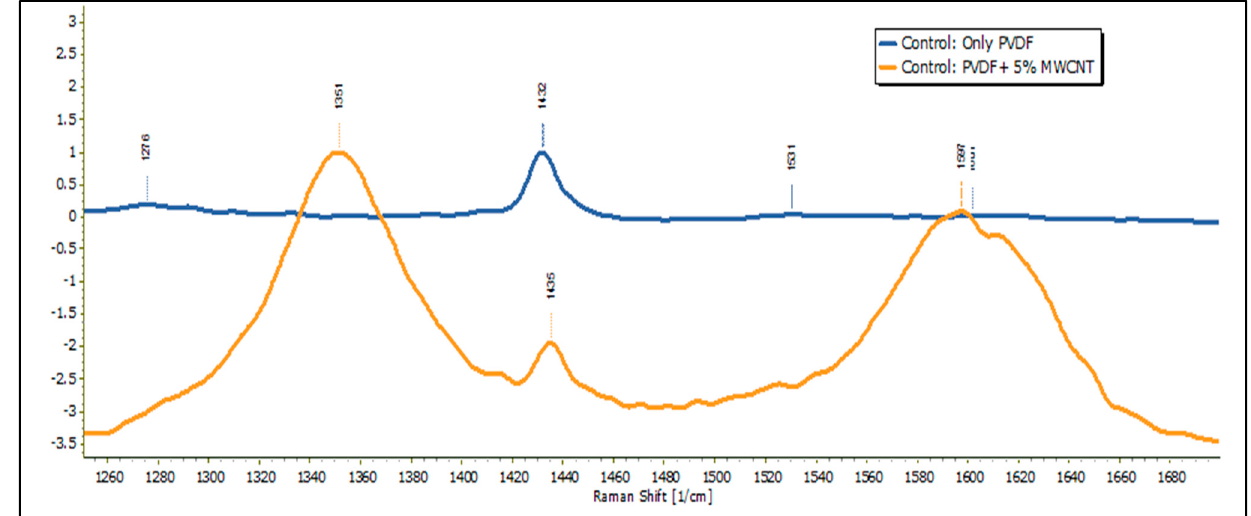
Figure 13. Raman results for Only PVDF and PVDF+ 5% MWCNT sample .